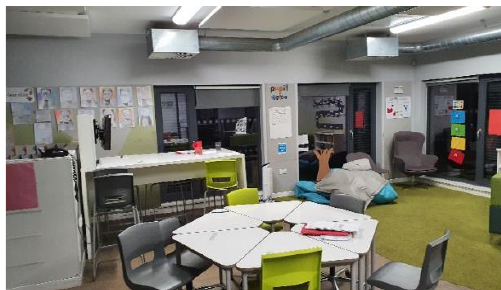
Figure 8. Picture of classroom B5.